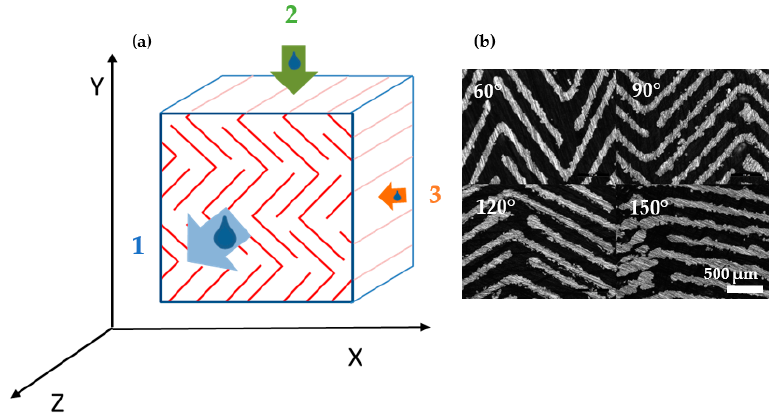
Figure 11. ( a ) Flow orientation in dependence of spatial structure orientation. Blue: direction 1 with unhindered flow independent of tilt angle α . Green: direction 2 with tunable flow ratio in dependence of tilt angle α —the more obtuse α , the more the flow is possible. Orange: direction 3 blocked flow direction. ( b ) Microscopic image of four angles α (clockwise starting upper left: 60°, 90°, 120°, 150°).